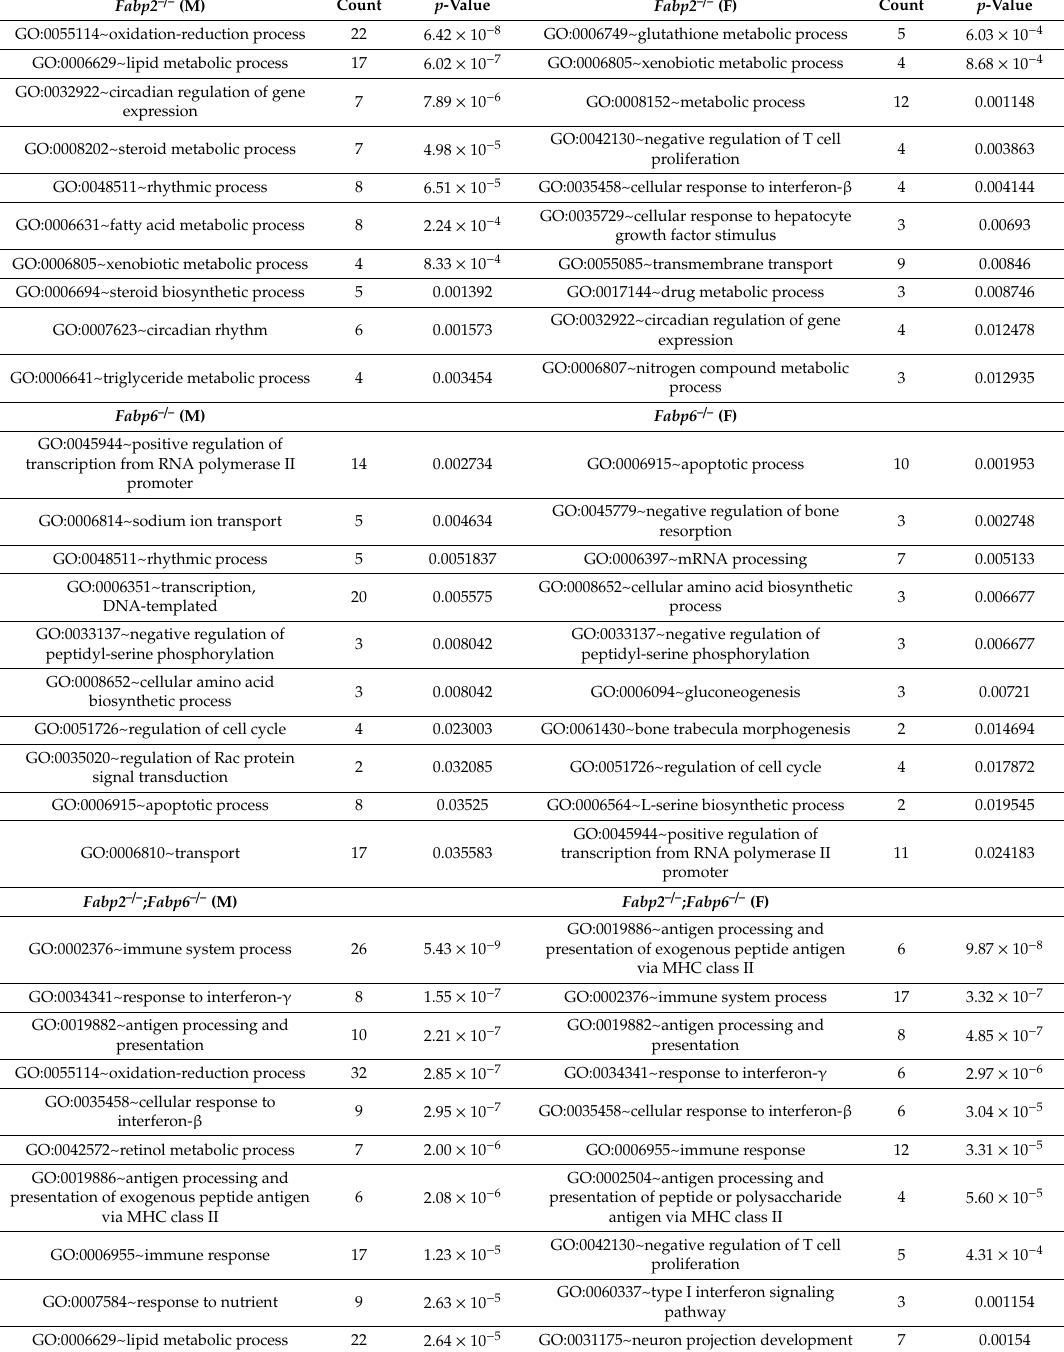
Table 1. Gene ontology analysis for the DE genes induced in di ff erent genotypes. The top 10 biological processes that are enriched in each genotype are shown, as are the number of genes that fall within each process (count) and the p -values